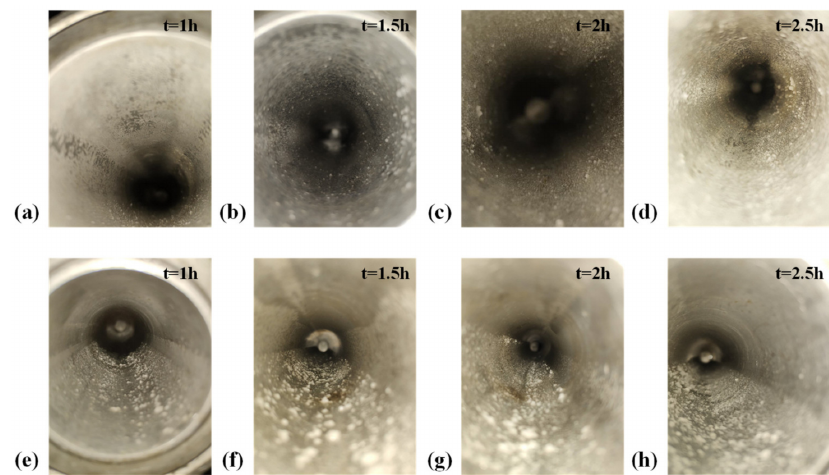
Figure 4. Ice accretion in the test-sections at different duration for T f = − 12 °C, γ TS = 200 ppm, V = 600 L/h. ( a – d ) are the ice accretion at upstream test section and ( e – h ) are the ice accretion at downstream test